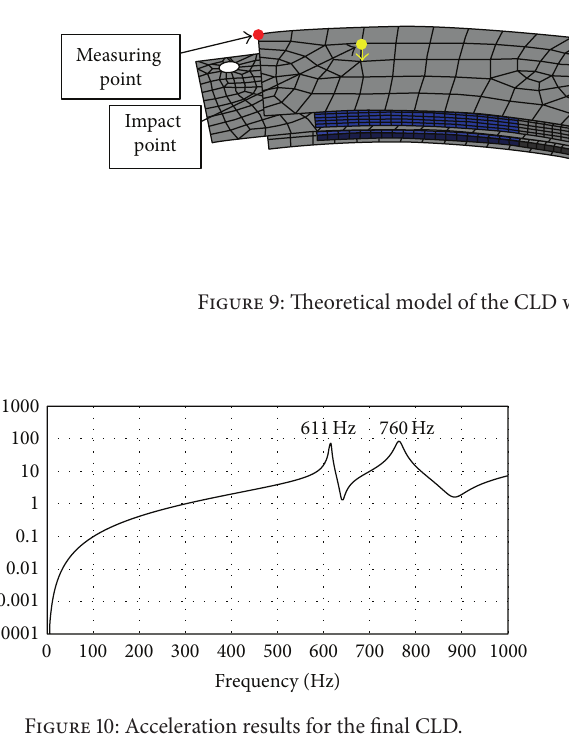
Figure 10: Acceleration results for the final CLD.